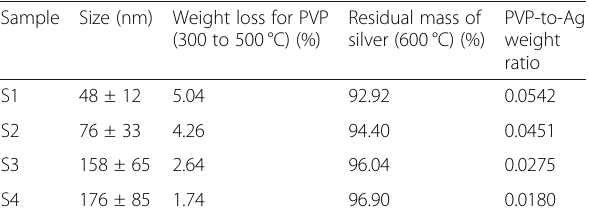
Table 2 Analysis data according to TGA curves of different sizes of Ag NP suspension (S1 to S4)